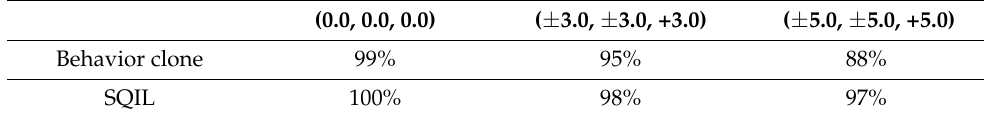
Table 3. Placement task robustness test.